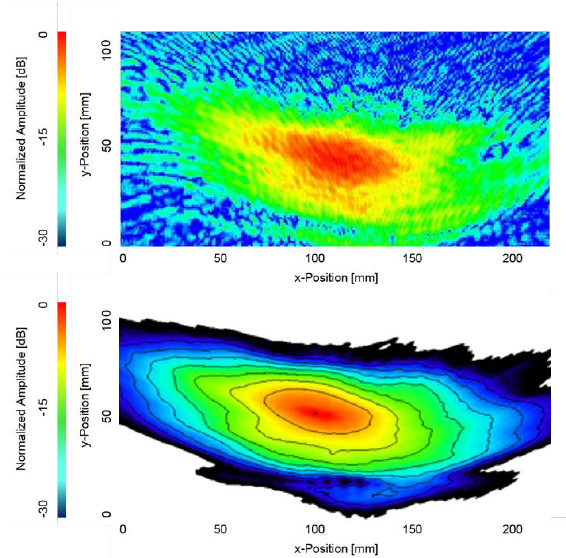
Fig. 7. Radiation pattern of the water-cooled launcher (top: cold measurement; bottom: corresponding simulation